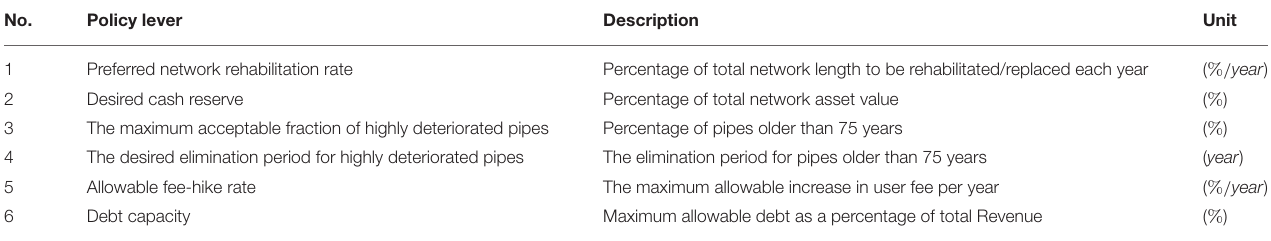
TABLE 3 | Policy levers for asset management strategy of water distribution